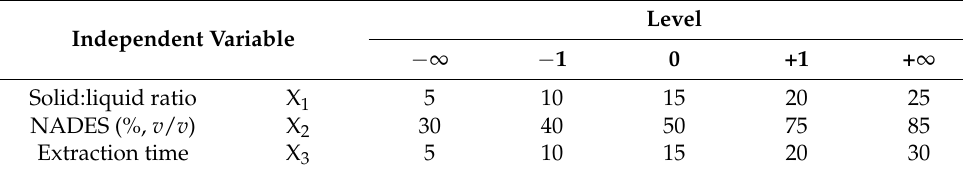
Table 3. Coded levels and independent